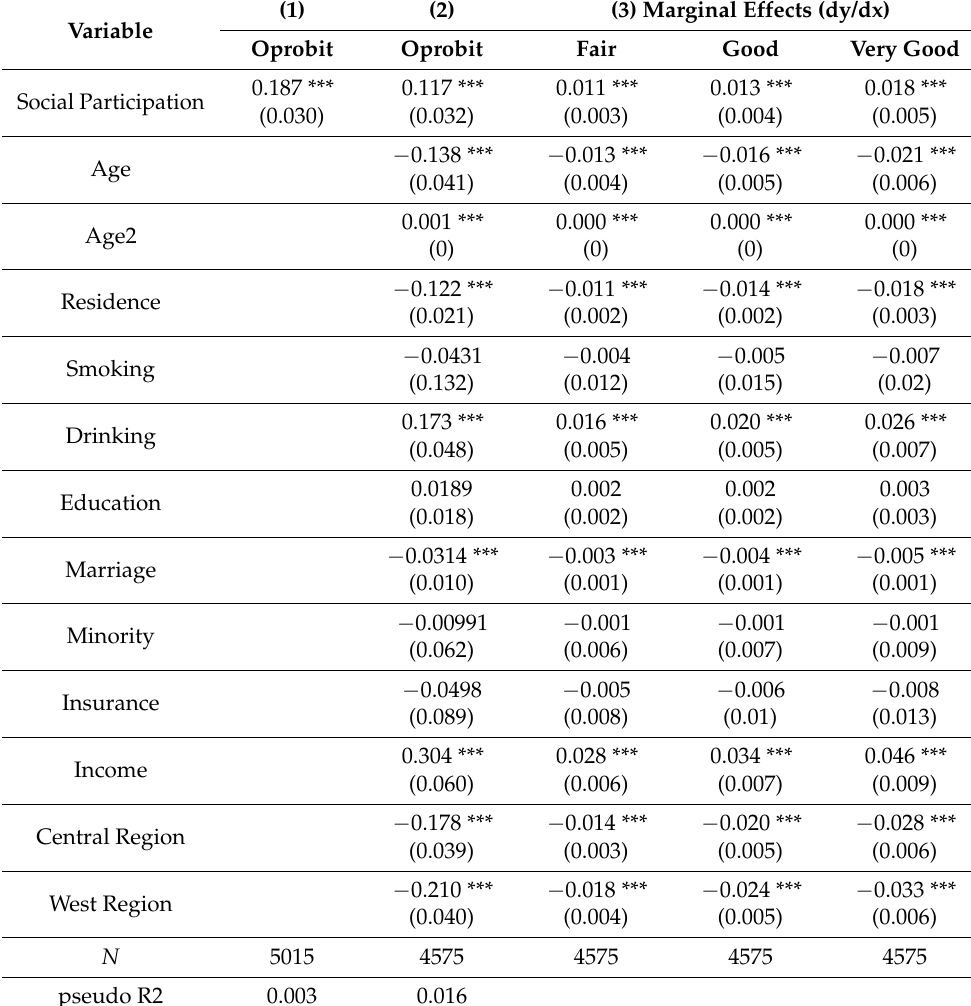
Table 3. Impacts of social participation on self-rated health of aging women ( N = 5015). (1) (2) (3) Marginal Effects (dy/dx) Variable Oprobit Oprobit Fair